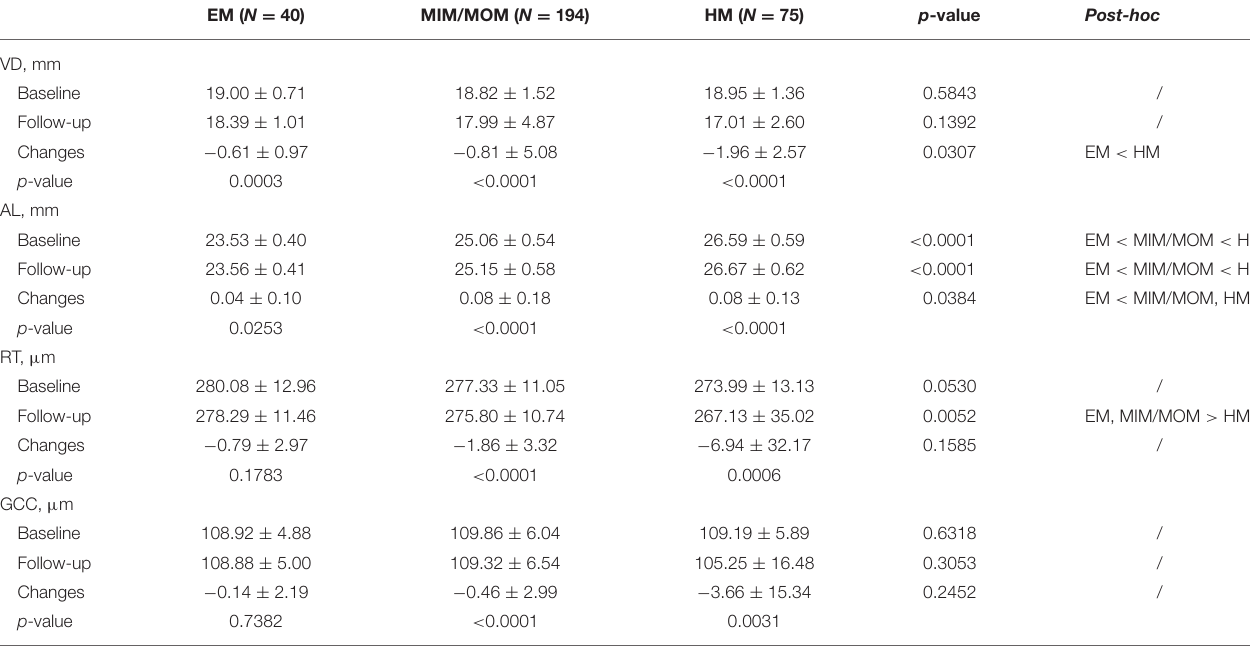
TABLE 2 | Comparison of globally VD and ocular parameters between baseline and the end of follow-up